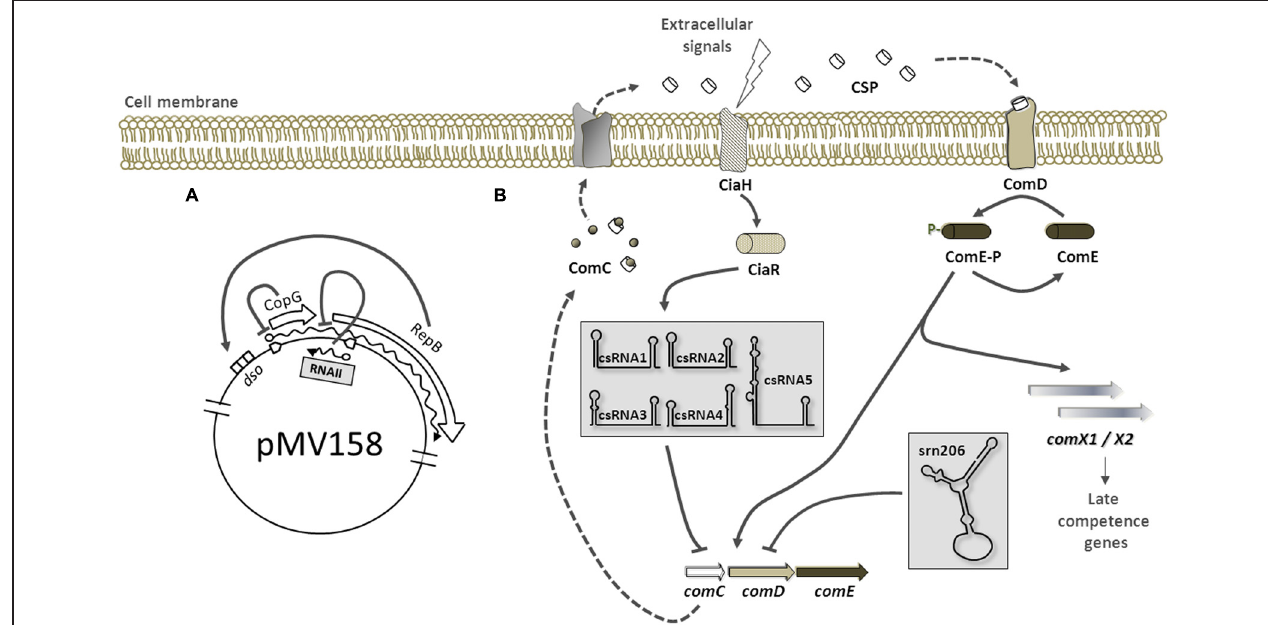
FIGURE 1 | Regulation by small RNAs (sRNAs) in pneumococci. The cytosol and the extracellular environment (upper part of the figure) are separated by the cell membrane. (A) Replication of plasmid pMV158 is initiated by RepB protein upon binding to double stranded origin (dso). RepB transcription is inhibited by CopG. The antisense RNAII represses RepB translation by base-pairing with the region immediately upstream of RepB translational initiation signals in the copG-repB message. (B) Postulated mechanism of competence regulation by sRNAs. The extracellular concentration of CSP, an exported peptide pheromone derived from precursor protein ComC, is sensed by the membrane histidine kinase ComD. Binding of CSP to ComD results in phosphorylation of ComD, which then transfers the phosphate group to the